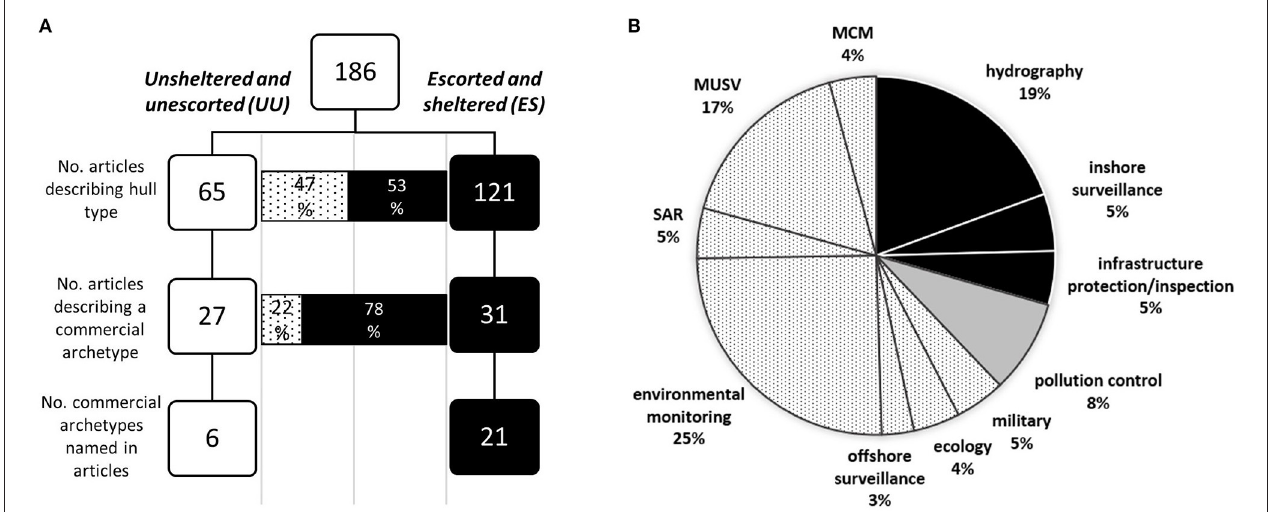
FIGURE 2 | Proportion of literature describing unescorted and unsheltered (UU) and escorted and sheltered (ES) operations in the literature description of environmental conditions, commercial make and available commercial prototypes (A) , and proportion of literature describing UU (dotted), ES (black) and UU or ES (grey) USV applications (B)